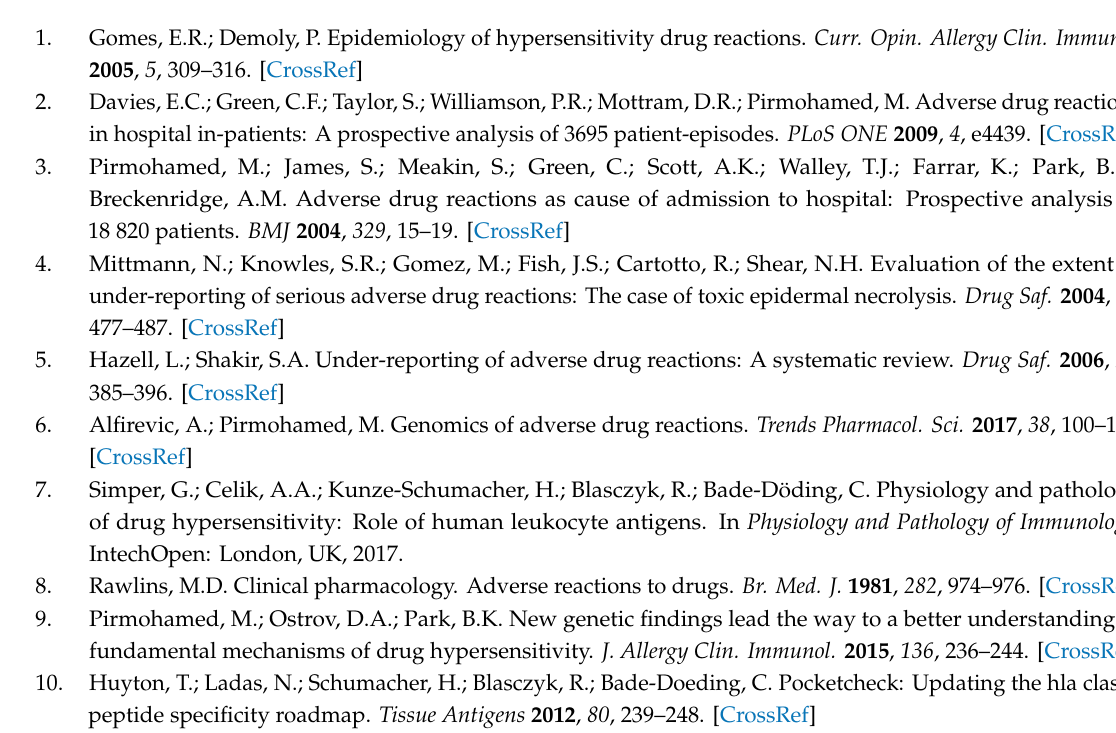
Figure S1. Solvent gradient for LC-MS analysis of peptides. Figure S2. Production of sA*31:01 is independent of TPN, whereas sB*15:02 requires TPN. The TPN + cell line LCL721.221 and the TPN- cell line LCL721.220 were lentivirally transduced with vectors encoding for sA*31:01 or B*15:02. The concentration of sHLA in cell culture supernatant of untransduced and transduced LCL721.221 and LCL721.220 cells was determined via HLA class I specific ELISA. Figure S3. Length of presented peptides after drug treatment. The length of peptides bound to sA*31:01 without (blue) treatment and after treatment with CBZ (red) and EPX (green). Table S1. Amino acid frequencies in sA*31:01-restricted low binding peptides produced in LCL721.221 cells. Table S2. Amino acid frequencies in sA*31:01-restricted high binding peptides produced in LCL721.221 cells. Table S3. Amino acid frequencies in sA*31:01-restricted low binding peptides produced in LCL721.220 cells. Table S4. Amino acid frequencies in sA*31:01-restricted high binding peptides produced in LCL721.220 cells. Table S5. Amino acid frequencies in sA*31:01-restricted low binding peptides produced in LCL721.221 cells treated with EPX. Table S6. Amino acid frequencies in sA*31:01-restricted high binding peptides produced in LCL721.221 cells treated with EPX. Table S7. Amino acid frequencies in sA*31:01-restricted low binding peptides produced in LCL721.221 cells treated with CBZ. Table S8. Amino acid frequencies in sA*31:01-restricted high binding peptides produced in LCL721.221 cells treated with